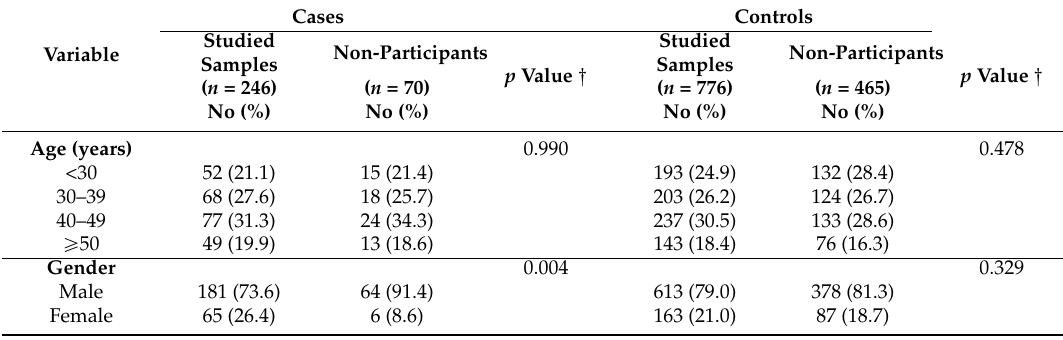
Age and sex distributions of studied samples and non-participants from both cases and controls.